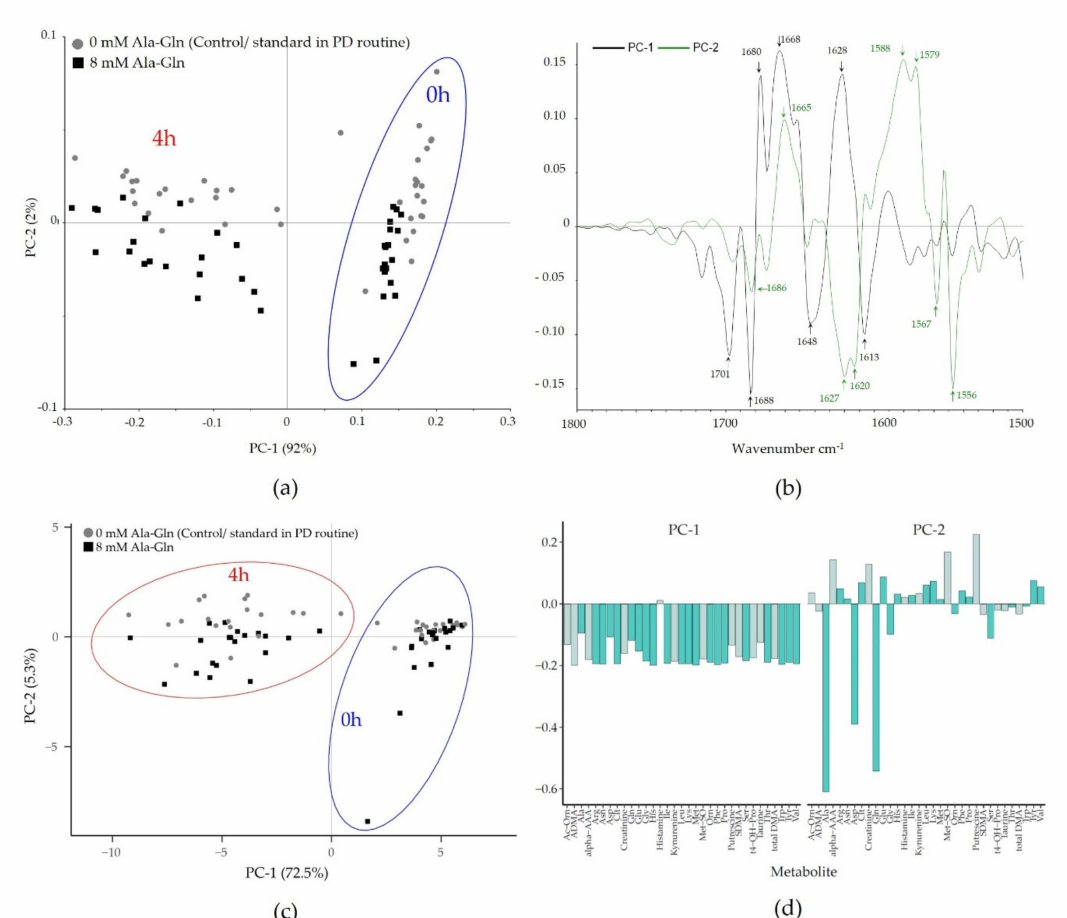
Figure 3. Unsupervised principal component analysis (PCA) for discrimination between 0 h and 4 h as well as Ala-Gln treated and untreated patients in Fourier-transform infrared (FTIR) spectroscopic and targeted metabolomics data. ( a ) PCA score plot from FTIR data based on the protein spectral region (1800–1500 cm − 1 ). PC1 was plotted against PC2. PC1 shows a distinct clustering between spectra from 0 h and 4 h derived samples, whereas PC2 discriminates the spectra of Ala-Gln treated and non-treated patients. The equivalent score plot for the polysaccharide region is provided in the Figure S1. ( b ) PCA loading plot identifies the Amide I region (1690–1620 cm − 1 ) to be mainly responsible between the spectra of the 0 h and 4 h sampling points. The Amide II region (1570–1515 cm − 1 ) also accounts for the separation between Ala-Gln untreated vs. treated PD samples. ( c ) In the targeted metabolomics data, PCA of 92 metabolites were included. The first PC represents 72.5% of the variation, followed by 5.3% by PC2. The biplot shows separation by dwell time, but not by treatment. ( d ) PCA loading plot indicates a uniform influence of most features on PC1, whereas the loadings of PC2 show a separation mainly by Ala, Gln, and Asp (dark green, canonical AA; gray, biogenic